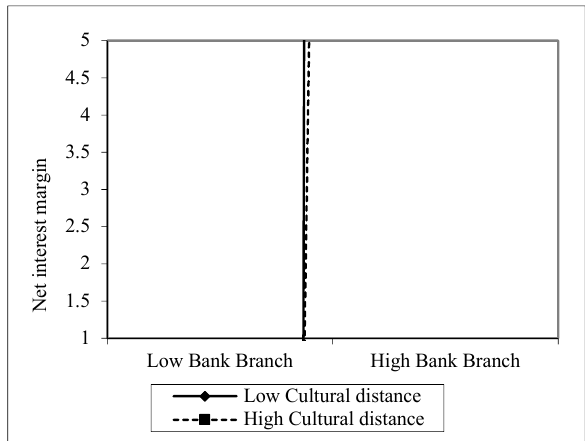
Figure 7. Bank Branch × Economic Freedom Distance.